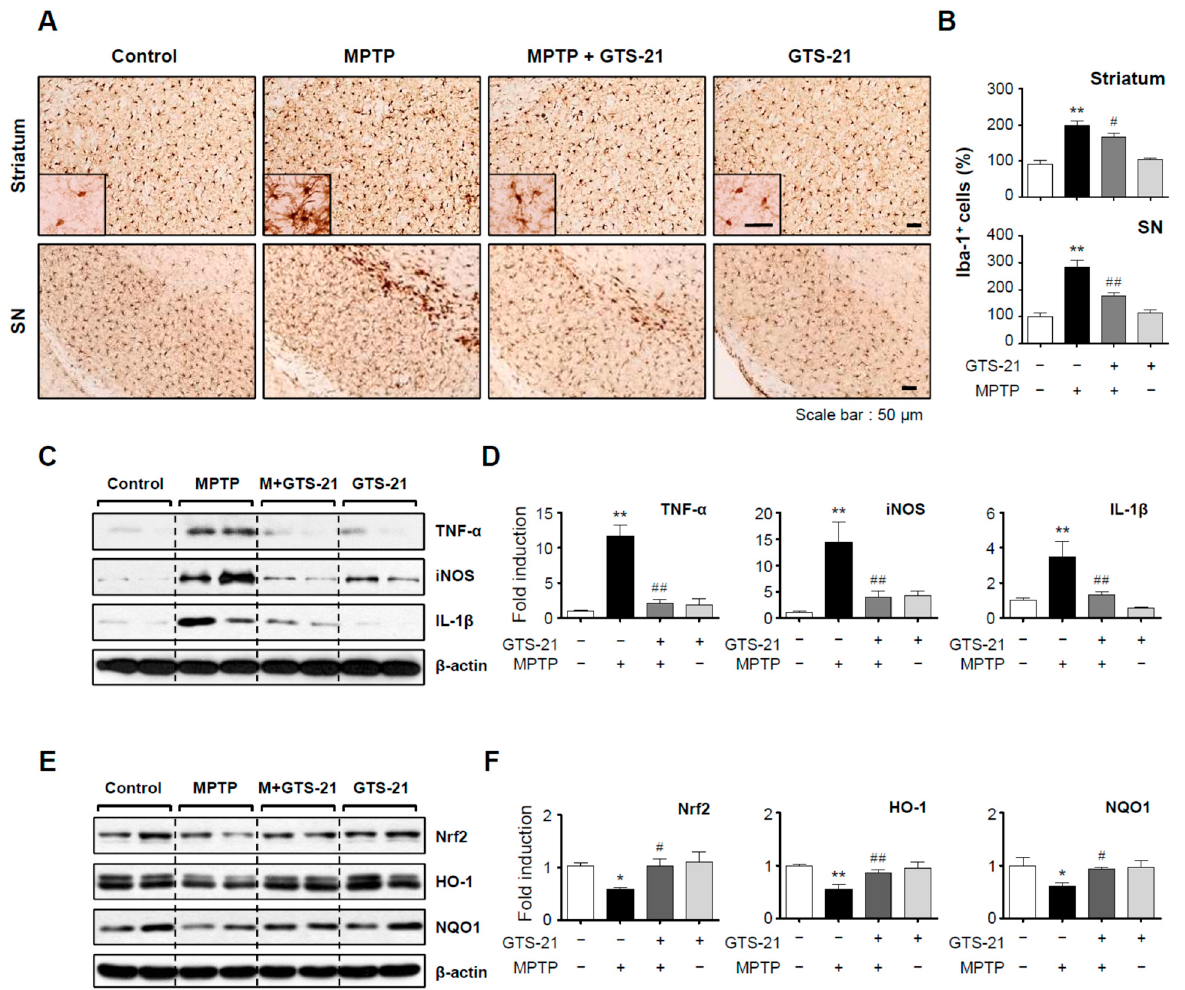
Figure 8. Effect of GTS-21 on microglial activation, inflammatory markers, and antioxidant enzyme expression in the brains of MPTP-injected mice. ( A ) Iba-1-positive microglial cells in the substantia nigra and striatum (representative images). ( B ) Quantitative analysis was performed by measuring the number of Iba-1-positive cells ( n = 4 per group, 3 sections/brain). ( C – F ) Protein extracts from the substantia nigra of each group were analyzed using TNF- α , iNOS, and IL-1 β antibodies or Nrf2, HO-1, and NQO1 antibodies ( n = 4). The figures show representative blots ( C , E ) and quantification data ( D , F ). The data are presented as the mean ± SEM. * p < 0.05, vs. control group; ** p < 0.01, vs. control group; # p < 0.05 vs. MPTP-treated group; ## p < 0.01 vs. MPTP-treated group.